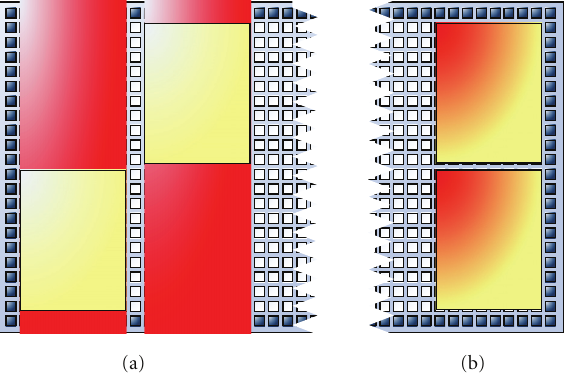
Figure 2: 1D and 2D placement constraints versus 1D and 2D